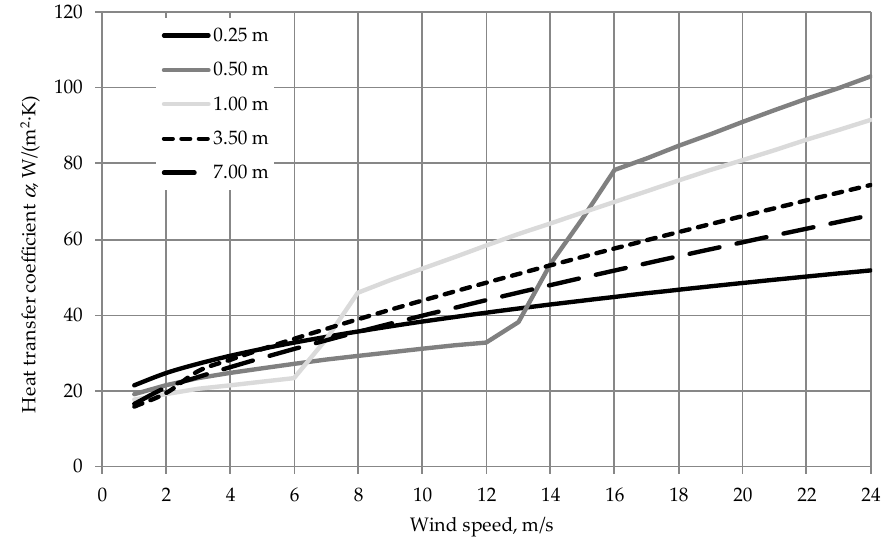
Figure 5. Relationship between the heat transfer coefficient to air α and wind velocity (HMA layer width d = 0,25 m–7,0 m).